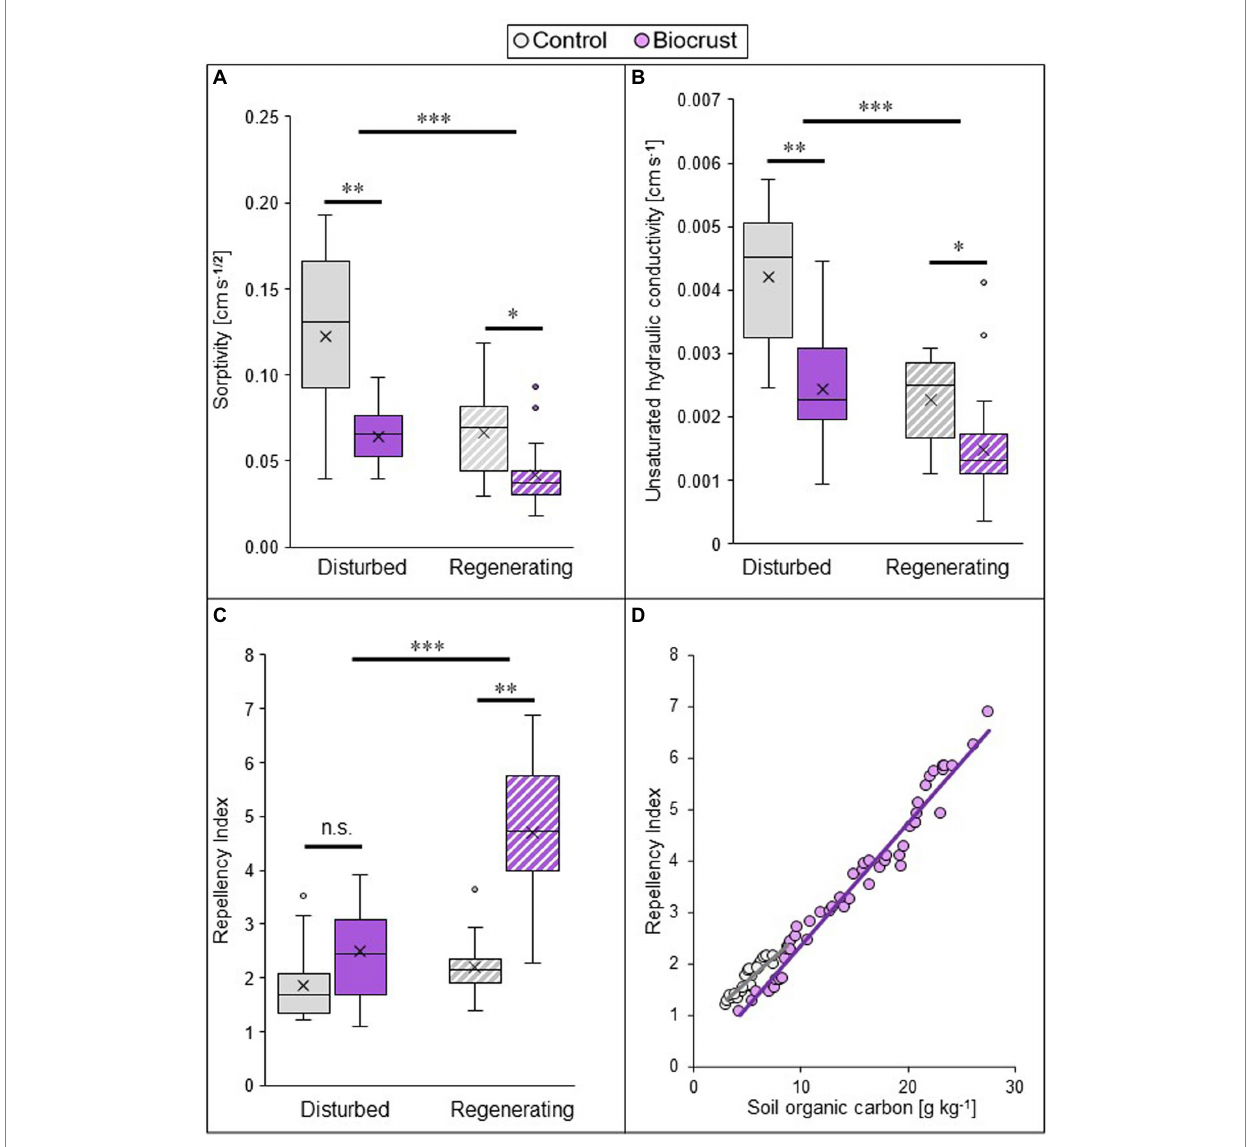
FIGURE 2 Biocrust and disturbance effects on soil hydrological parameters of two study sites in the Caatinga dry forest, NE Brazil. Sorptivity (A) , unsaturated hydraulic conductivity (B) , and repellency index (C) values measured at a pressure head of h 0 = − 4 cm, and the relationship between repellency index and soil organic carbon content (D) of biocrusts (purple) and bare soil patches (control, grey) in a disturbed (filled in boxes) and regenerating (striped boxes) site in the Caatinga, NE Brazil. For (A–C) boxes represent the interquartile distance between the first and third quartile, the horizontal line the median, the cross the statistical mean, and the antennas the next closest point from an outlier within the data set. n = 25 for biocrusts and n = 20 for controls. Black bars and asterisks describe statistical differences within groups (control vs. biocrust) per site and between groups (disturbed vs. regenerating); p < 0.05 = *; p < 0.01 = **, p < 0.001 = ***. Post hoc -test results can be found in Table S2. For (D) , data from both case study sites were pooled ( n = 50 for biocrusts and n = 25 for control soils). SOC data taken from Szyja et al. (2019). Pearson’s r = 0.98; p < 0.001 for biocrust and r = 0.92; p < 0.0001 for